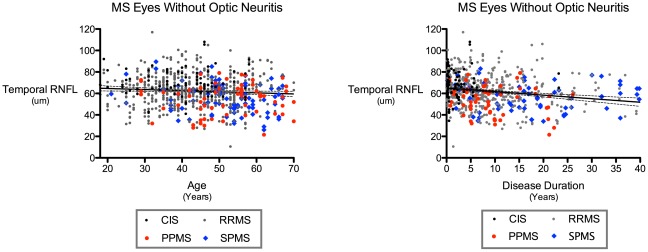
Associations of Temporal Retinal Nerve Fiber Layer Thickness by Disease Stage and Subtype with Age and Disease Duration in MS.Temporal quadrant peripapillary retinal nerve fiber layer (RNFL) thickness by age (A) and disease duration (B) in MS patients in eyes without a history of symptomatic optic neuritis. Note that temporal RNFL thickness is nearly identical between patients with primary and secondary progressive MS, but disease durations tend to be greater in SPMS and shorter in PPMS for the same degree of RNFL loss. The solid line indicates the slope as fitted by linear regression, and the dotted lines denote 95% confidence intervals. CIS = Clinically Isolated Syndrome; RRMS = Relapsing-Remitting MS; PPMS = Primary Progressive MS; SPMS = Secondary Progressive MS.